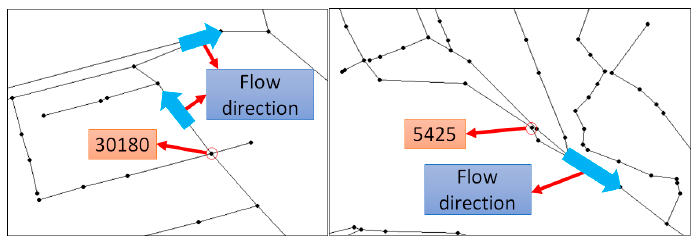
Figure 10. Monitoring node locations in the target watershed.